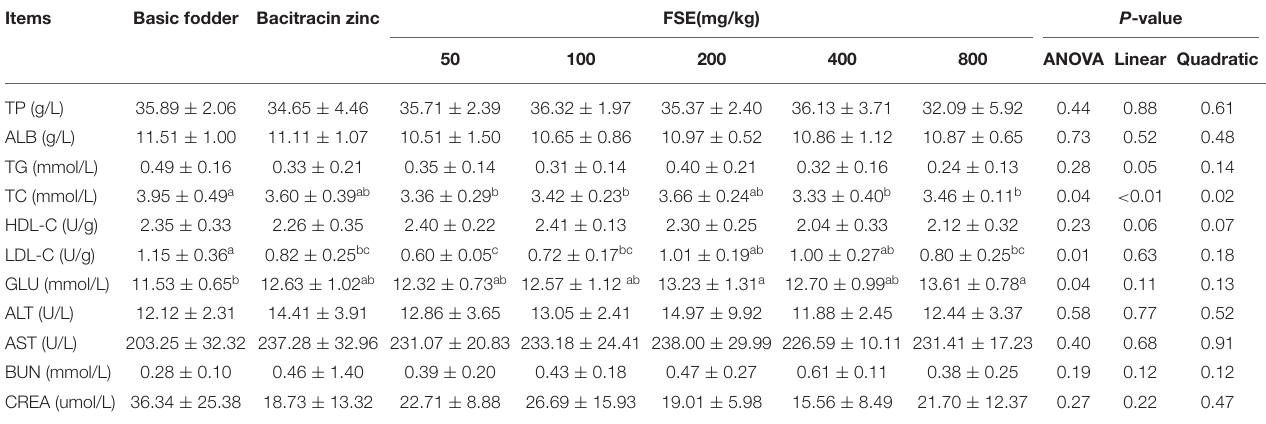
TABLE 6 | Effects of fenugreek seed extract on serum biochemistry in broilers 1 . Items